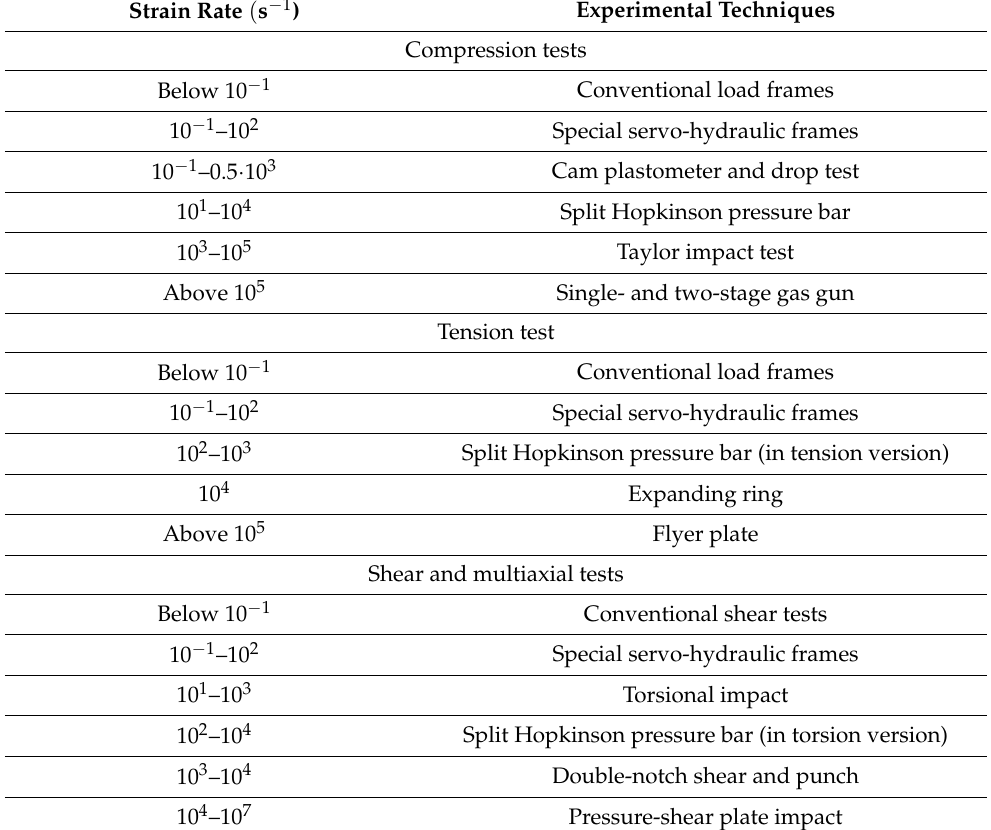
Table 2. Experimental research taking into account the ranges of the strain rate.